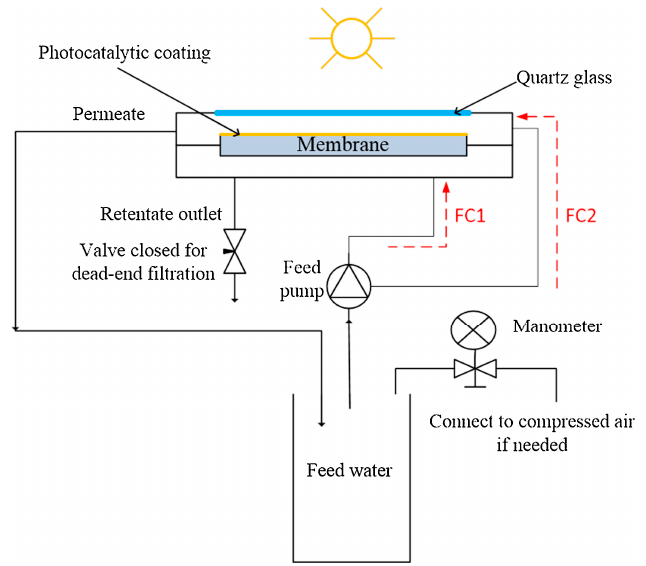
Figure 3. Schematic diagram of a lab-scale PMR system with two flow configurations for carbamazepine removal under solar light. Adapted with permission from [57], Copyright Elsevier, 2016.